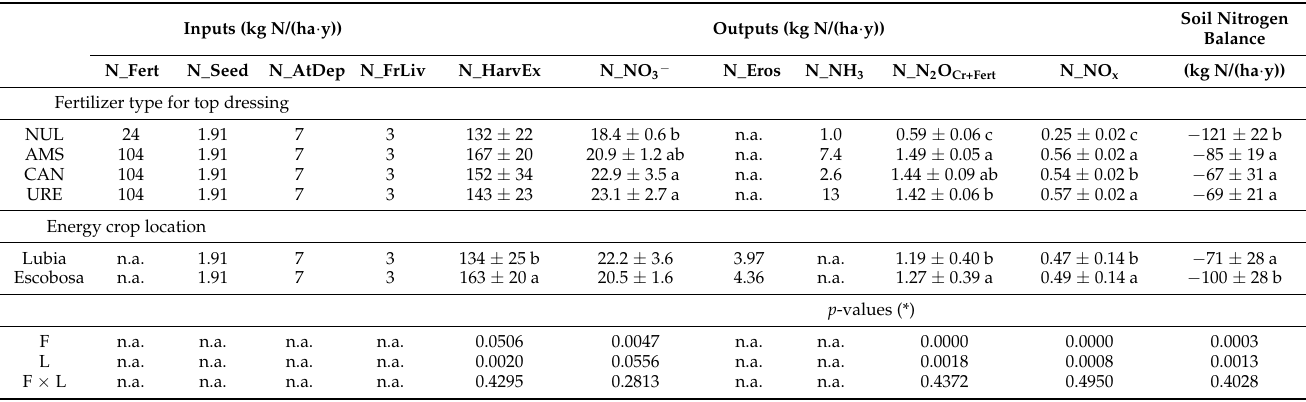
Table 6. Soil nitrogen balance (means ± standard deviations) depending on the N fertilizer type used for top dressing and location. Input and output codes were described in Section 2.3.